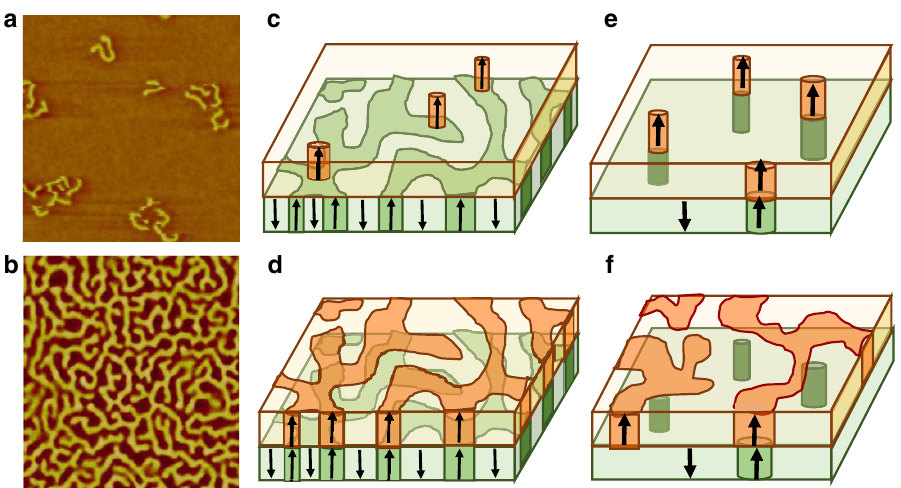
Figure 5 | Magnetic domain topology in the [Co/Pd]/IrMn film at nucleation and in the coercive region under various FC conditions. ( a , b ) MFM (5 (cid:2) 5 m m 2 ) images taken at room temperature showing the magnetic domains in the F Co/Pd layer ( a ) at the nucleation stage and ( b ) in the coercive region ( M B 0). ( c , d ) Sketches of the domain configuration for ZFC and moderate field-cooled states ( c ) at nucleation/saturation and ( d ) at the coercive point. ( e , f ) Sketches of the domain configuration in near-saturating field-cooled state ( e ) at nucleation/saturation and ( f ) at the coercive point. The imprinted pattern in the AF layer is shown in green, the domain pattern in the F layer is shown in orange. Arrows indicate magnetization